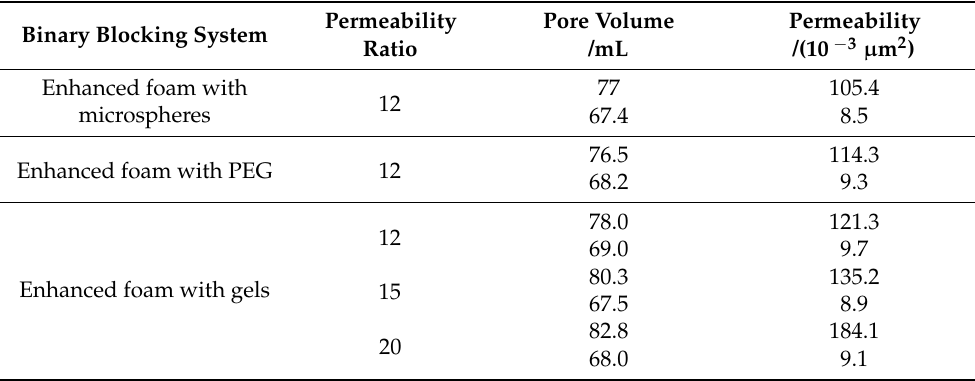
Table 2. Parameters of the twin-tube model of the sand pack. Binary Blocking